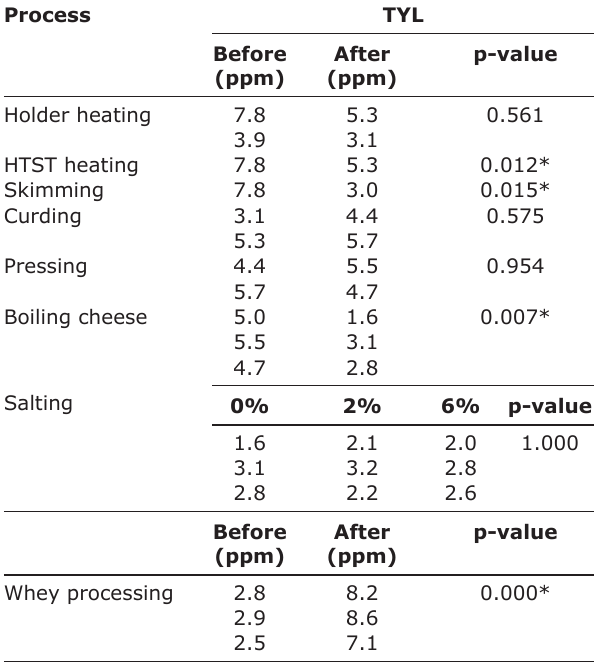
Table - 2: Effect of different processes on TYL